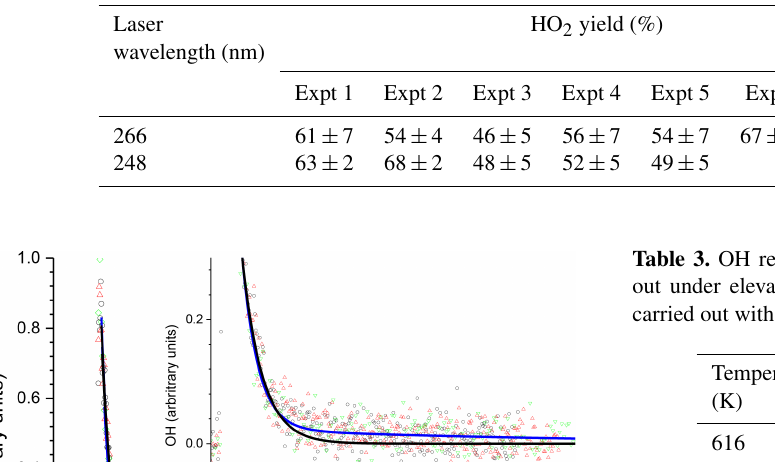
Table 2. HO 2 yields from experiments carried out at room temperature (293–298K) with reaction initiated by photolysis of H 2 O 2 at 248 and 266nm.